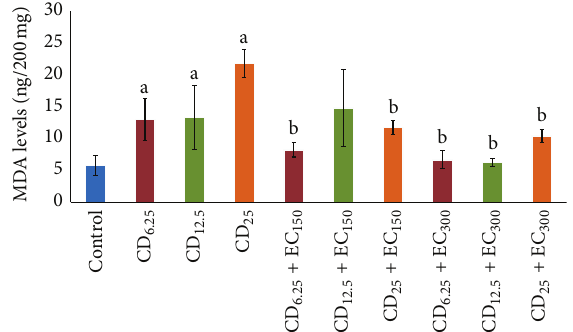
Figure 3: The levels of lung MDA. The lung MDA levels were increased in coal dust-exposed groups at all doses than that in non-exposure group but decreased in the E. cottonii -supplemented groups, except in CD 12.5 + EC 150 group. a 𝑃 < 0.05 in comparison with non-exposure group, b 𝑃 < 0.05 in comparison with its coal dust-exposed nonsupplemented group. Non-exposure group (control); group exposed to coal dust at dose of 6.25 mg/m 3 (CD 6.25 ), 12.5 mg/m 3 (CD 12.5 ), or 25 mg/m 3 (CD 25 ); group supplemented with the ethanolic extract of E. cottonii at dose of 150 (EC 150 ) or 300 mg/kgBW (EC 300